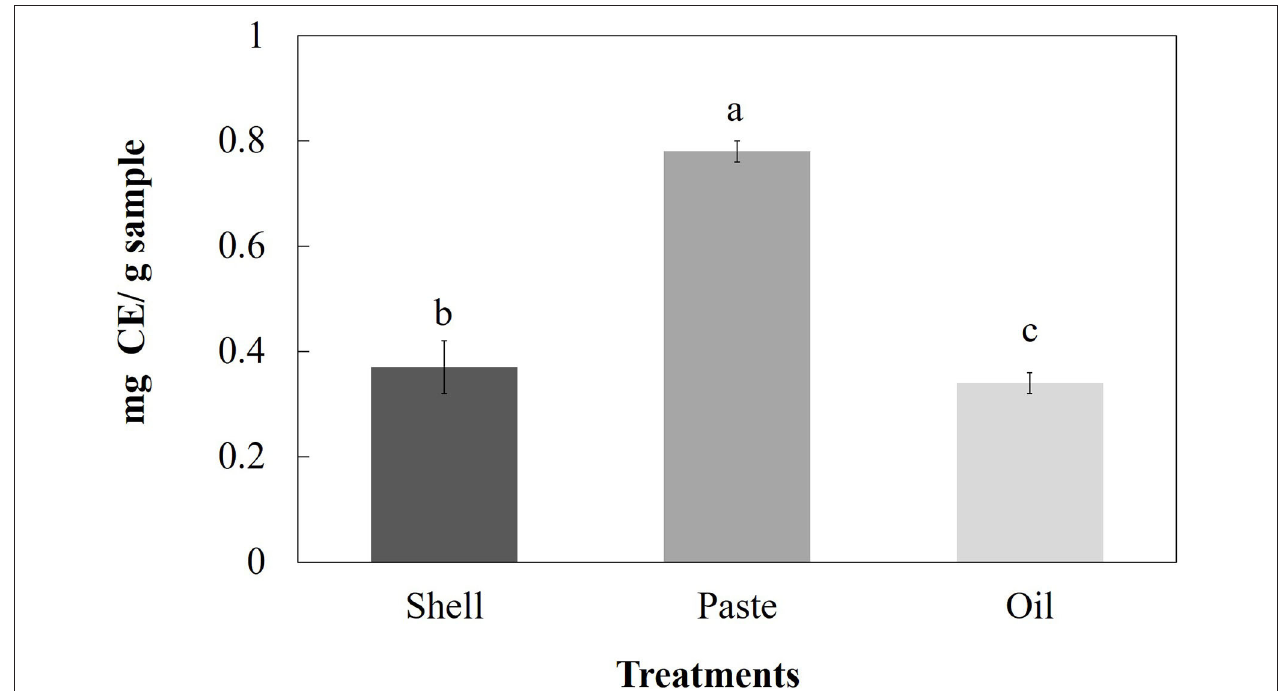
FIGURE 4 | Flavonoid content of various almond by-products extracted with ethanol. The vertical bars indicate mean ± standard deviation ( n = 3).